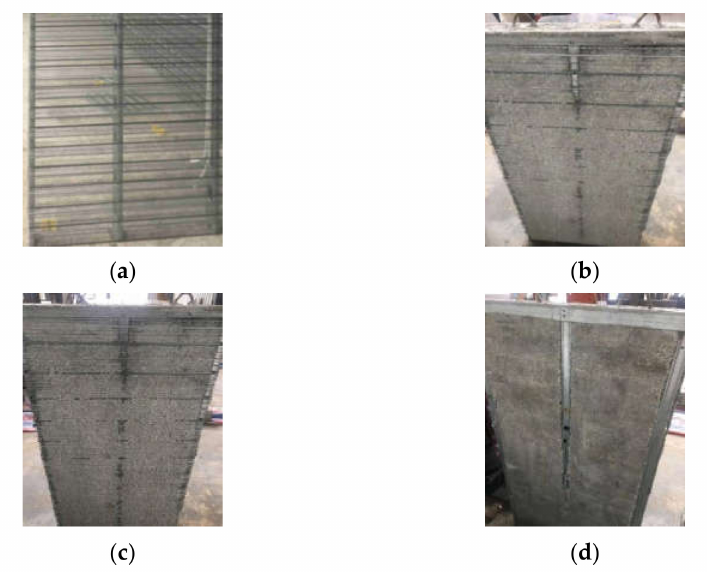
Figure 2. Solid model diagram of test piece. ( a ) W1; ( b ) W2; ( c ) W3; ( d ) W4.